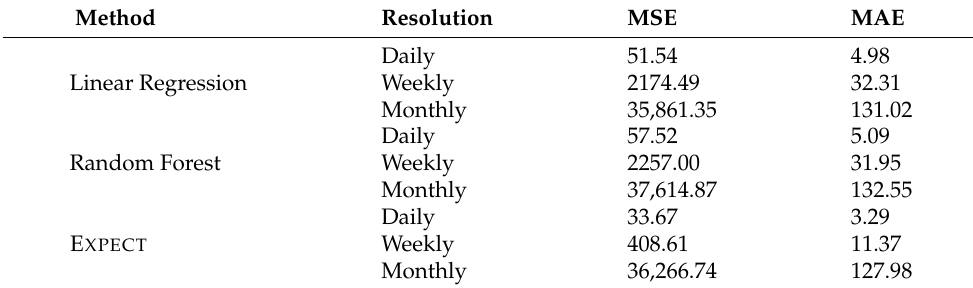
Table 6. Performance evaluation with SDC and